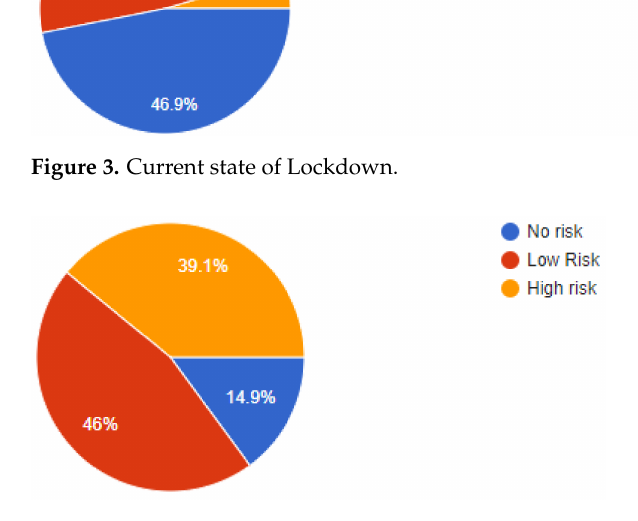
Figure 4. Risk perception of dentists.